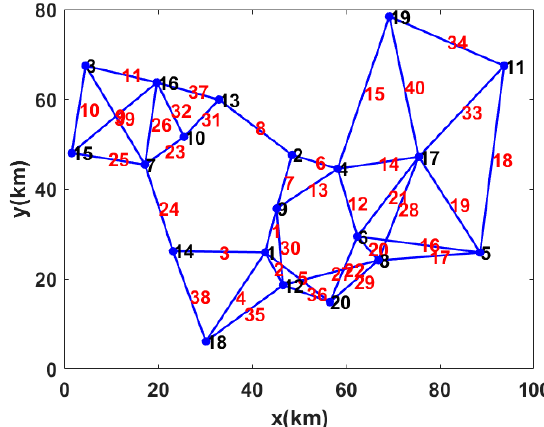
Figure 3. The basic topological structure of OFSCI network.